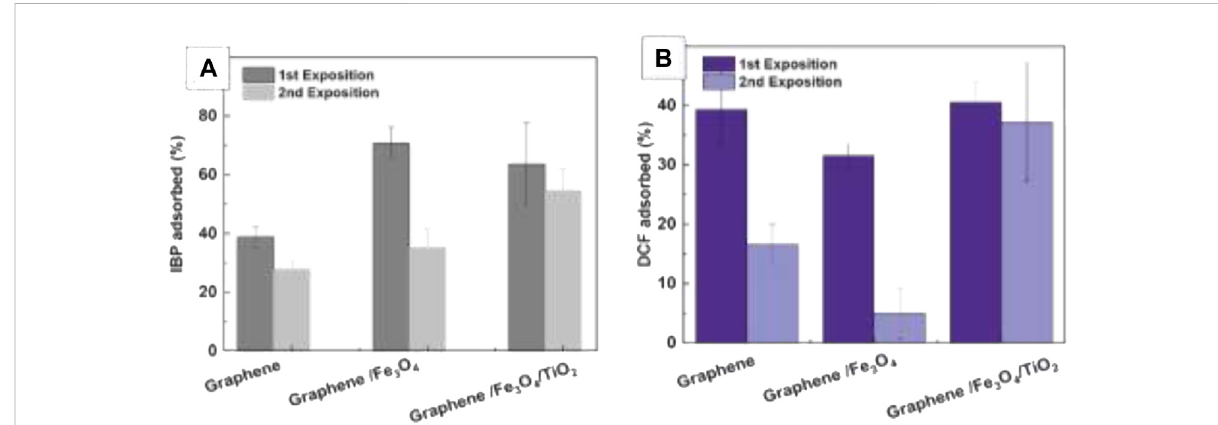
FIGURE 7 Photocatalytic degradation of adsorbed species by TiO 2 NPs Concentration of the studied drugs IBP (A) and DCF (B) after different hybrid con fi gurations havebeen exposedtoEC50solutions.Signi fi canterrorbarsarethestandarddeviationofthreecompletely independent samples(not